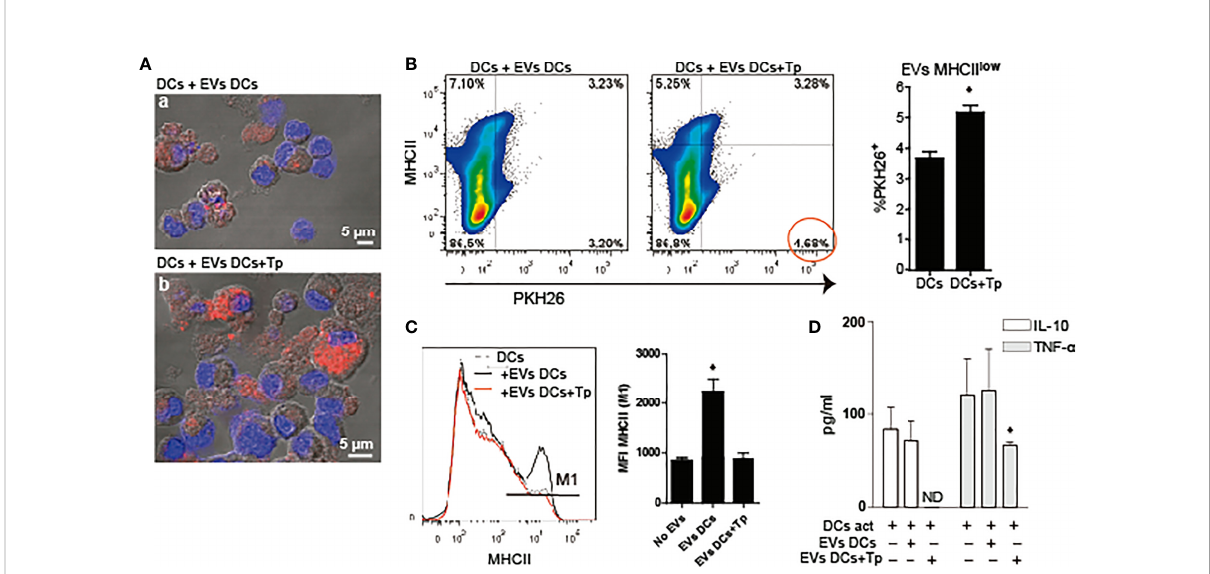
FIGURE 3 DCs-derived EVs are internalized by DCs in culture. (A) Confocal microscopy of DCs incubated with PKH26 + EVs (red) derived from DCs (a) or DCs+Tp (b) for 24 h at 37°C. Scale indicates 5 µM. (B) Analysis of MHCII expression associated to PKH26 + EVs uptake by DCs in culture by fl ow cytometry. Statistical analysis was performed with Student´s t -test, * p <0.05. (C) Analysis of MHCII median fl uorescence intensity (MFI) in DCs stimulated or not with EVs-DCs or EVs-DCs+Tp. Statistical analysis was performed with ANOVA and Dunnett´s test, * p <0.05. (D) TNF- a and